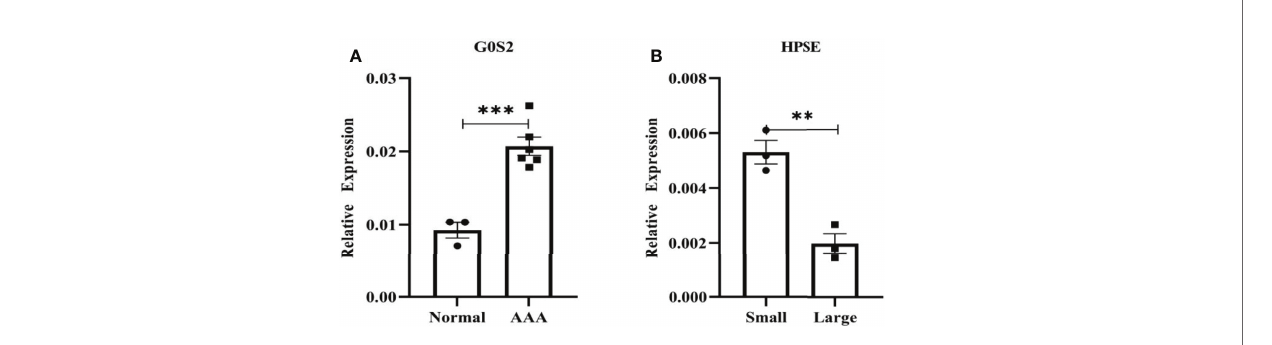
FIGURE 11 | Veri fifi cation of G0S2 and HPSE by qRT-PCR. (A) G0S2 showed the signi fifi cant upregulation in AAA tissues. (B) HPSE showed a signi fifi cant upregulation in small AAA samples. **P < 0.01, ***P